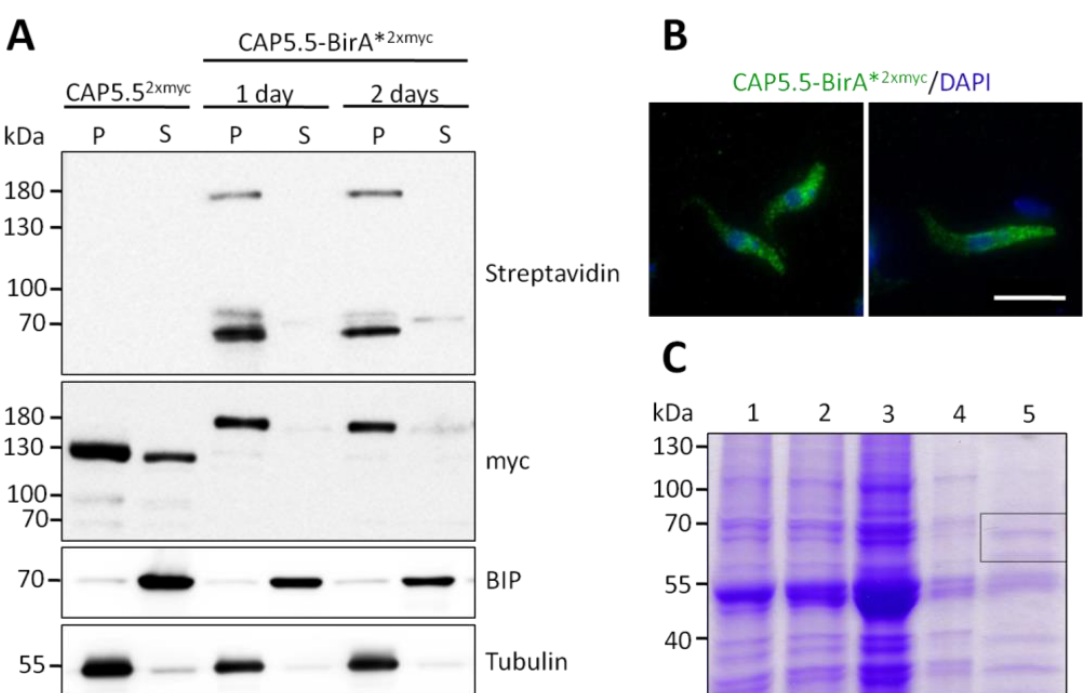
Figure 1. A CAP5.5-BirA*expressing cell line to identify CAP5.5 proximal proteins by BioID. ( A ) Ectopic expression of CAP5.5-myc-BirA*-myc (here simplified termed as CAP5.5-BirA* 2xmyc ) in procyclic trypanosomes (PC449) was induced by 1 µ g/mL doxycycline with an excess of biotin in the culture medium. Samples were taken after 1 and 2 days and fractionated in the soluble (S) and the pellet (P) fraction using 1% NP40. Biotinylated proteins were detected by HRP conjugated streptavidin. CAP5.5-myc-BirA*-myc was detected using an anti-myc antibody. Cells ectopically expressing CAP5.5 2xmyc were used as control. BIP and tubulin served as the loading control for the soluble and the insoluble fractions. ( B ) Localisation of the CAP5.5-myc-BirA*-myc protein over the cell body in whole cells (left image) and 1% NP40 extracted cells (right image). Cells were stained using an antibody against the myc-tag and DAPI to stain the DNA. Scale bar, 10 µ m. ( C ) Proteins of the pellet fraction were solubilised and biotinylated proteins were purified by a Strep-Tactin ® gravity flow column: 1, input, 2, flow through, 3, 4 wash fractions and 5, elution fractions pooled. The framed area of the gel, corresponding to the 60–70 kD mass range, was cut out and analysed by mass spec- trometry.